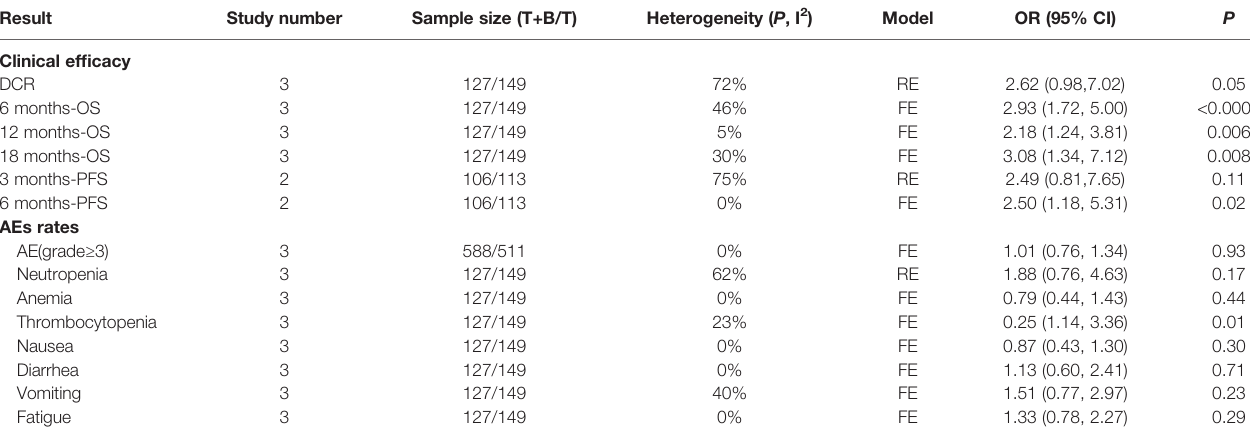
TABLE 2 | Summary of the results of the meta-analysis.